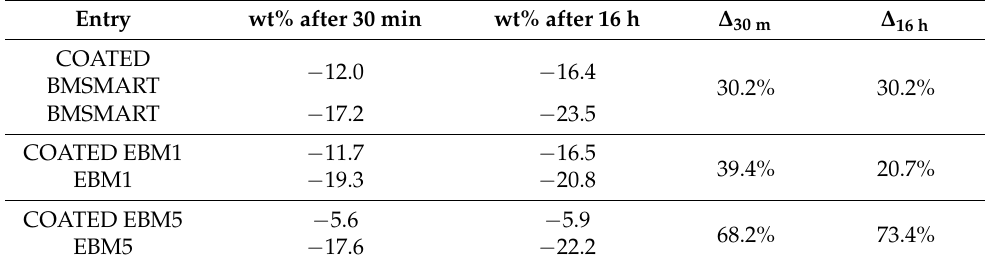
Table 2. Extracted fraction in water.